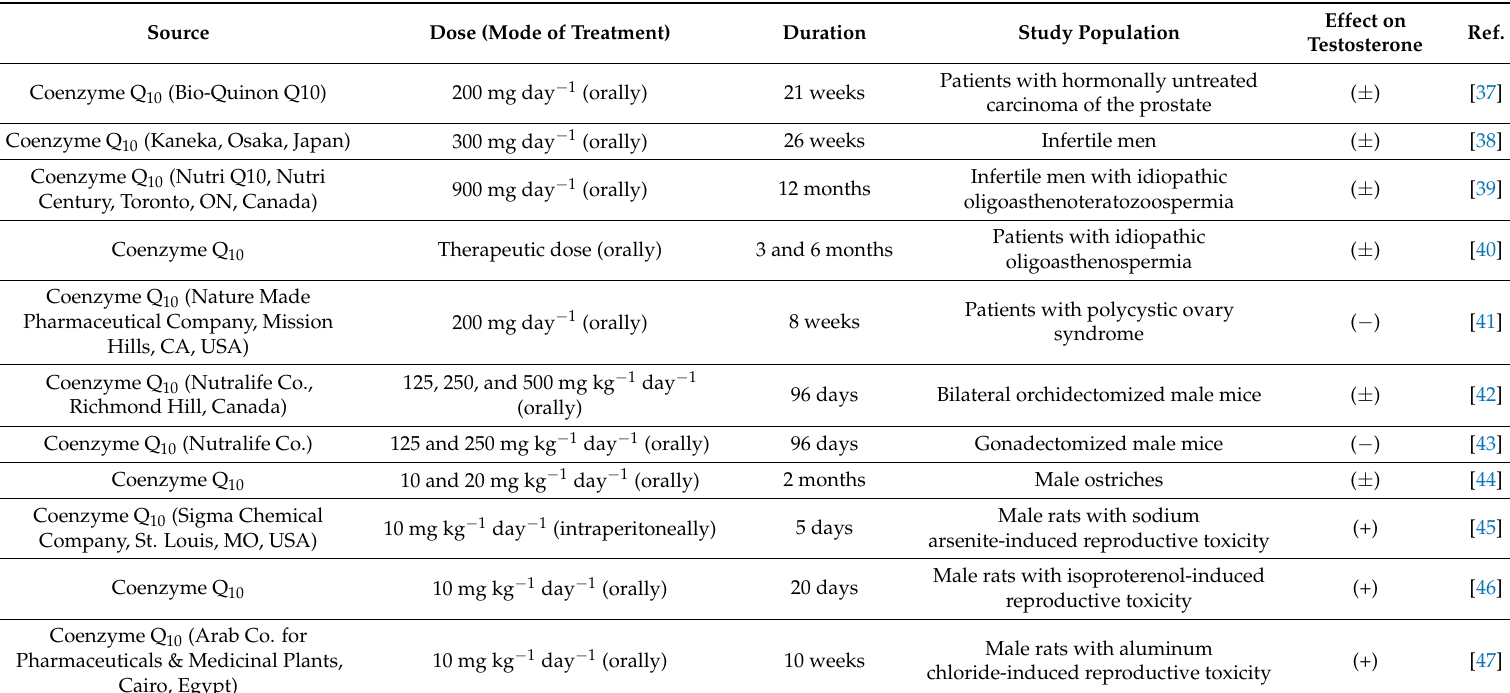
Table 1. A summary of the main research studies conducted on coenzyme Q 10 and its reported effects on